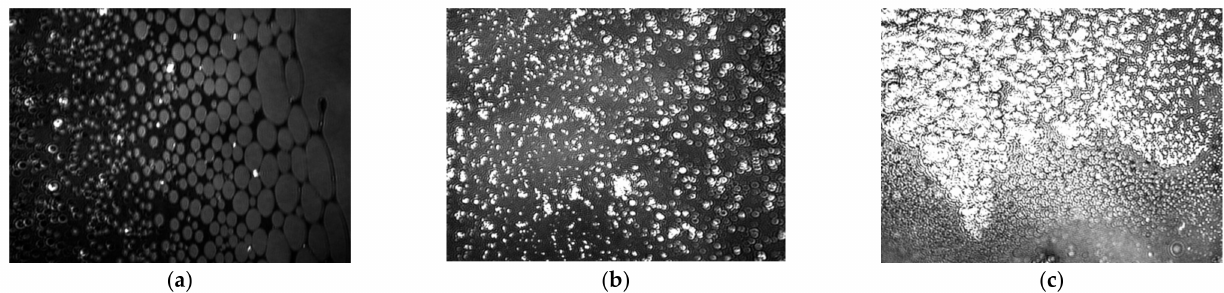
Figure 6. BAM images were taken for myricetin for three surface pressure: ( a ) 0.21 mN/m, ( b ) 20.61 mN/m, ( c ) 48.93 mN/m.The images were captured during compression at constant temperature and surface pressure in the field of view 3.6 × 4.0 mm. A black glass plate immersed in the subphase absorbed the refracted beam. The resolution of image was approx. 6 µ